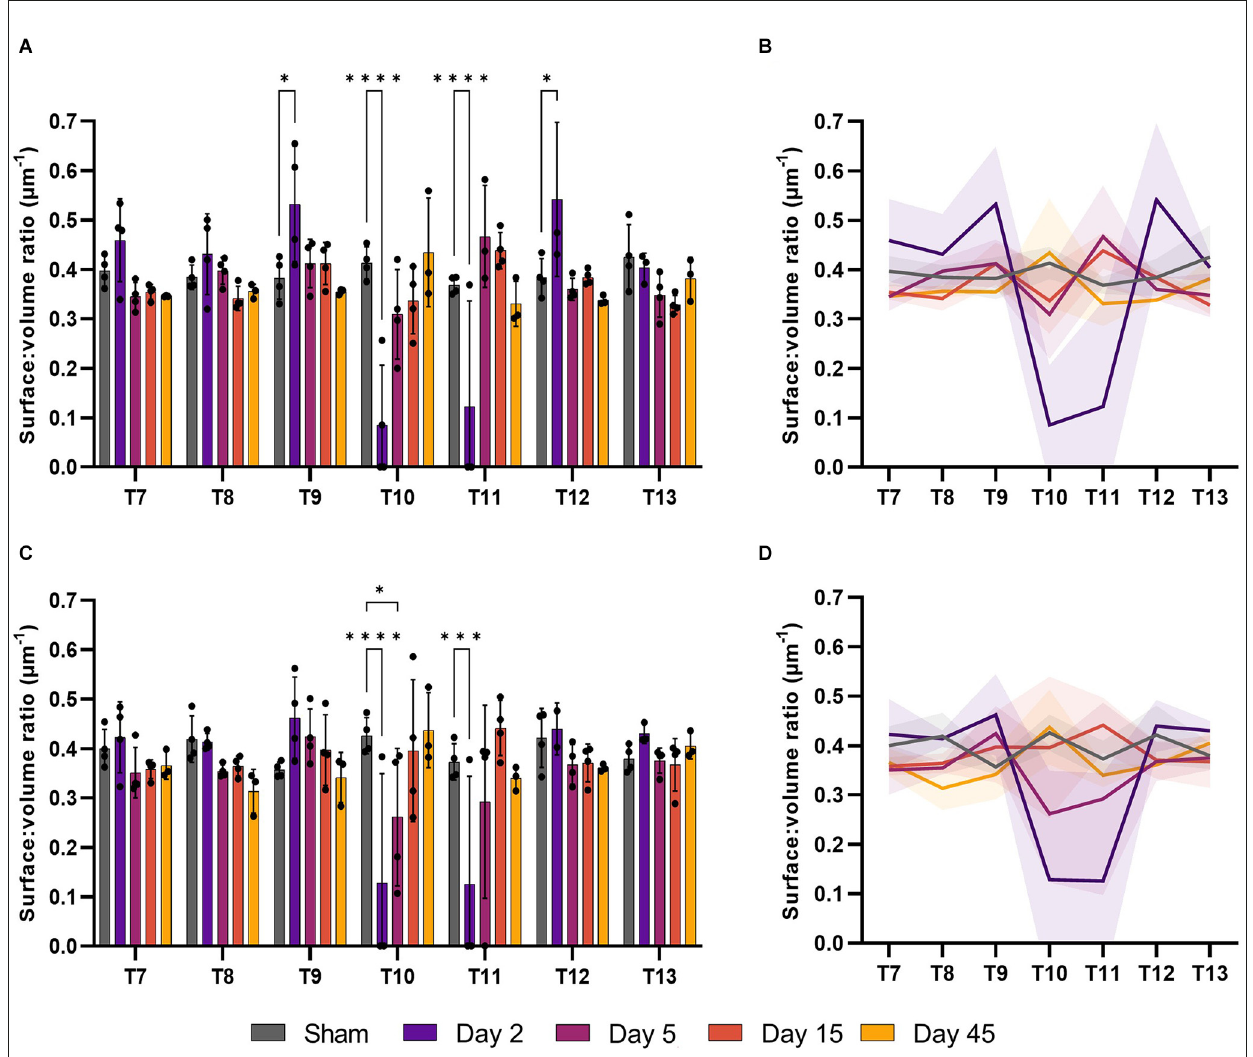
FIGURE4 The surface:volume ratio (S/V) was disrupted after spinal cord injury. Microvessel S/V increased at day 2 in the ventral grey matter of T9 and T12 ( P < 0.05) relative to sham operated controls (A) . S/V decreased at the injury epicentre (T10) at day 2 in the ventral grey matter ( A , P < 0.0001) and at days 2 and 5 in the dorsal grey matter ( C , P < 0.0001 and P < 0.05 respectively). Trend lines show the pattern of changes over time across seven spinal segments in the ventral (B) and dorsal (D) grey matter. ∗ P < 0.05, ∗∗∗ P < 0.001, ∗∗∗∗ P < 0.0001. Error bars ± SD. n = 3/4 for all groups.